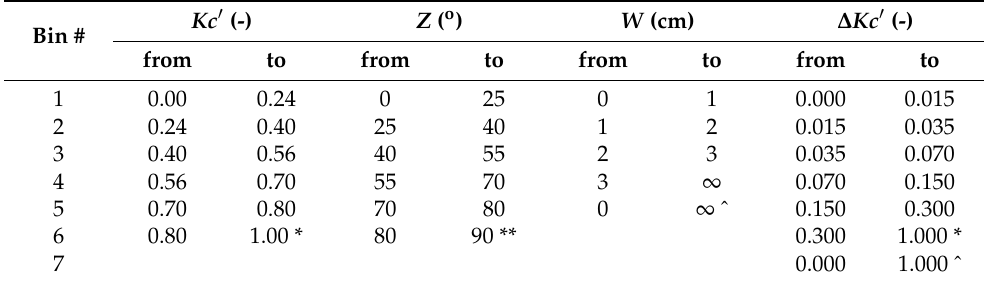
Table 2. Bins used for four insolation condition dimensions X (Kc (cid:48) , Z , W , ∆ Kc (cid:48) ). Kc (cid:48) (-) Z ( o ) W (cm) ∆ Kc (cid:48) (-) Bin # from to from to from to from to 1 0.00